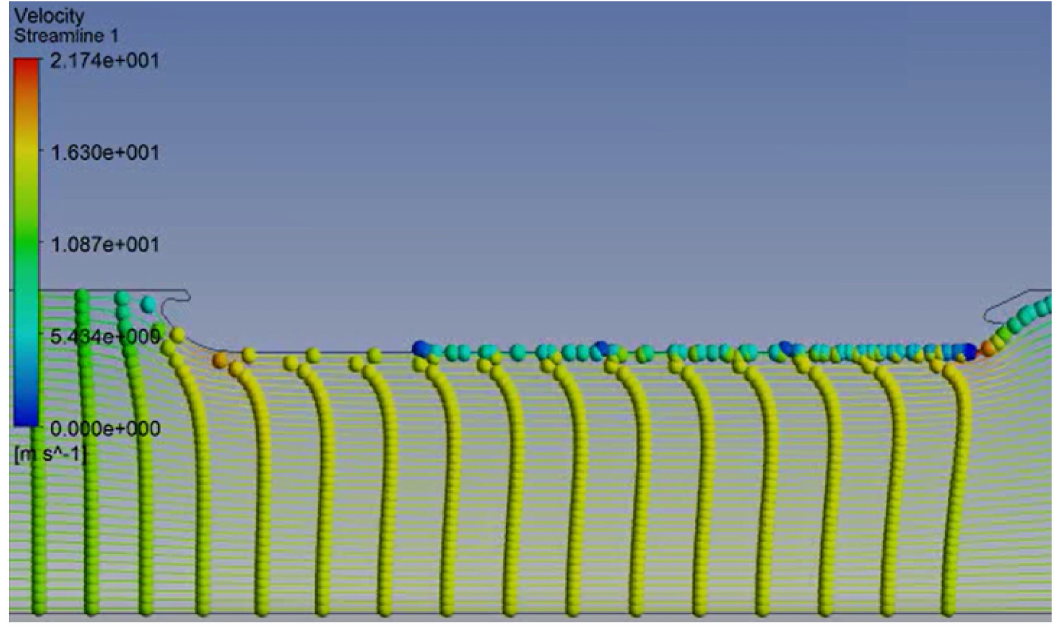
Figure 8. Virtualization of the flow Seawater and